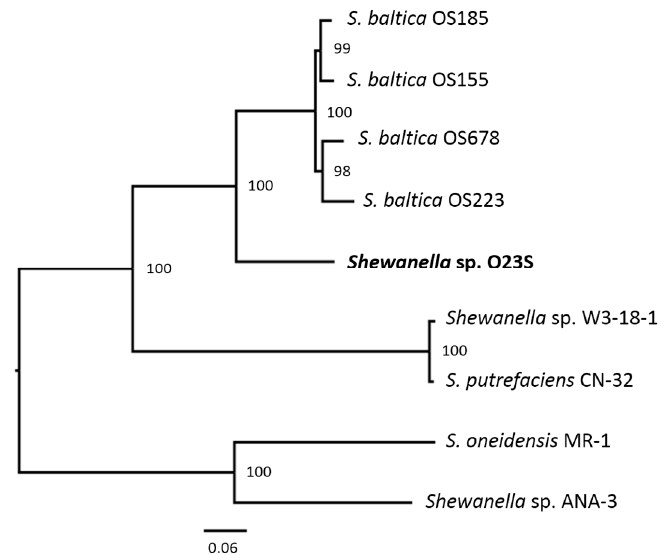
Figure 2. Phylogenetic tree of Shewanella spp. to which Shewanella sp. O23S shows the highest resemblance. The phylogenetic placement of O23S was determined based on the comparison of global protein families selected from the representative closest genomes identified as a part of PATRIC automatic annotation. The bootstrap support values are shown next to the